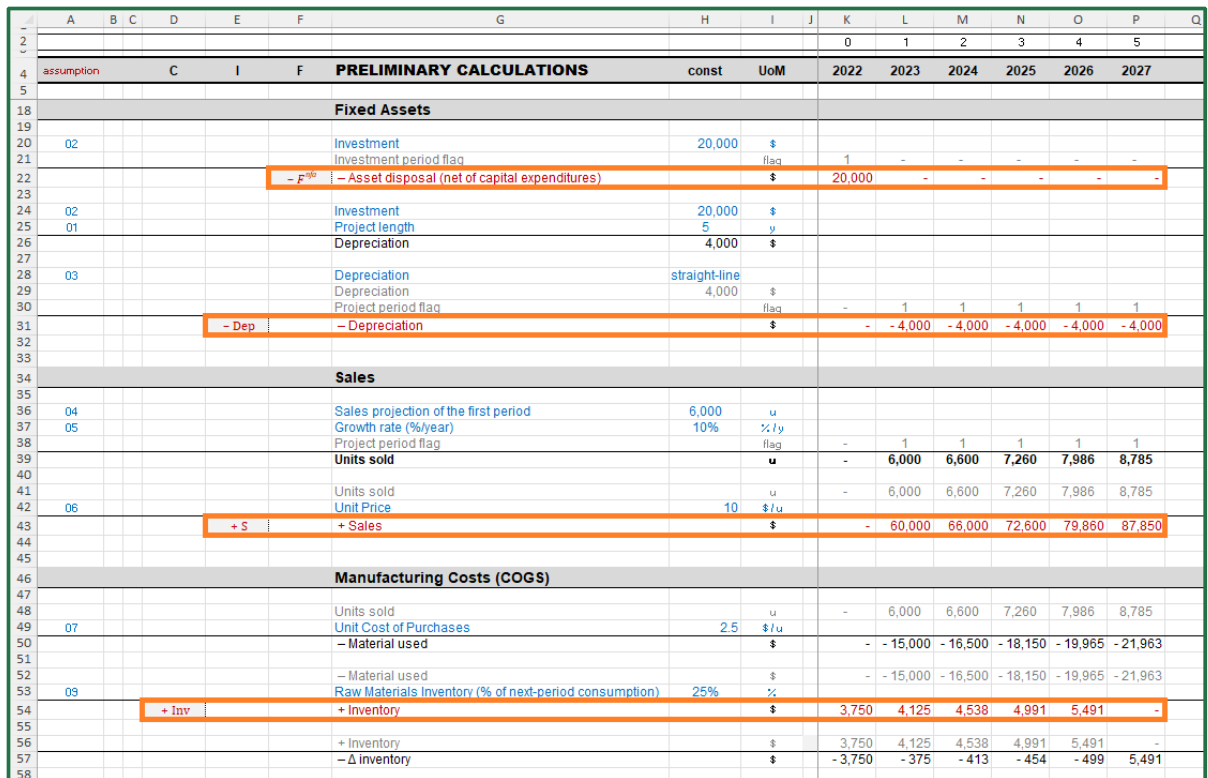
Figure 4. Examples of preliminary calculations (“PreCalc” sheet). Each column represents one period, and the rows contain the values taken on by the various variables. Columns A:G contain descriptions regarding the variables; column H contains the constant values (i.e., the values that are independent of the period); column I contains the unit of measurement of the variables; columns K to P contain the amounts of periods 0 through 𝑛 = 5 (last period of the project).